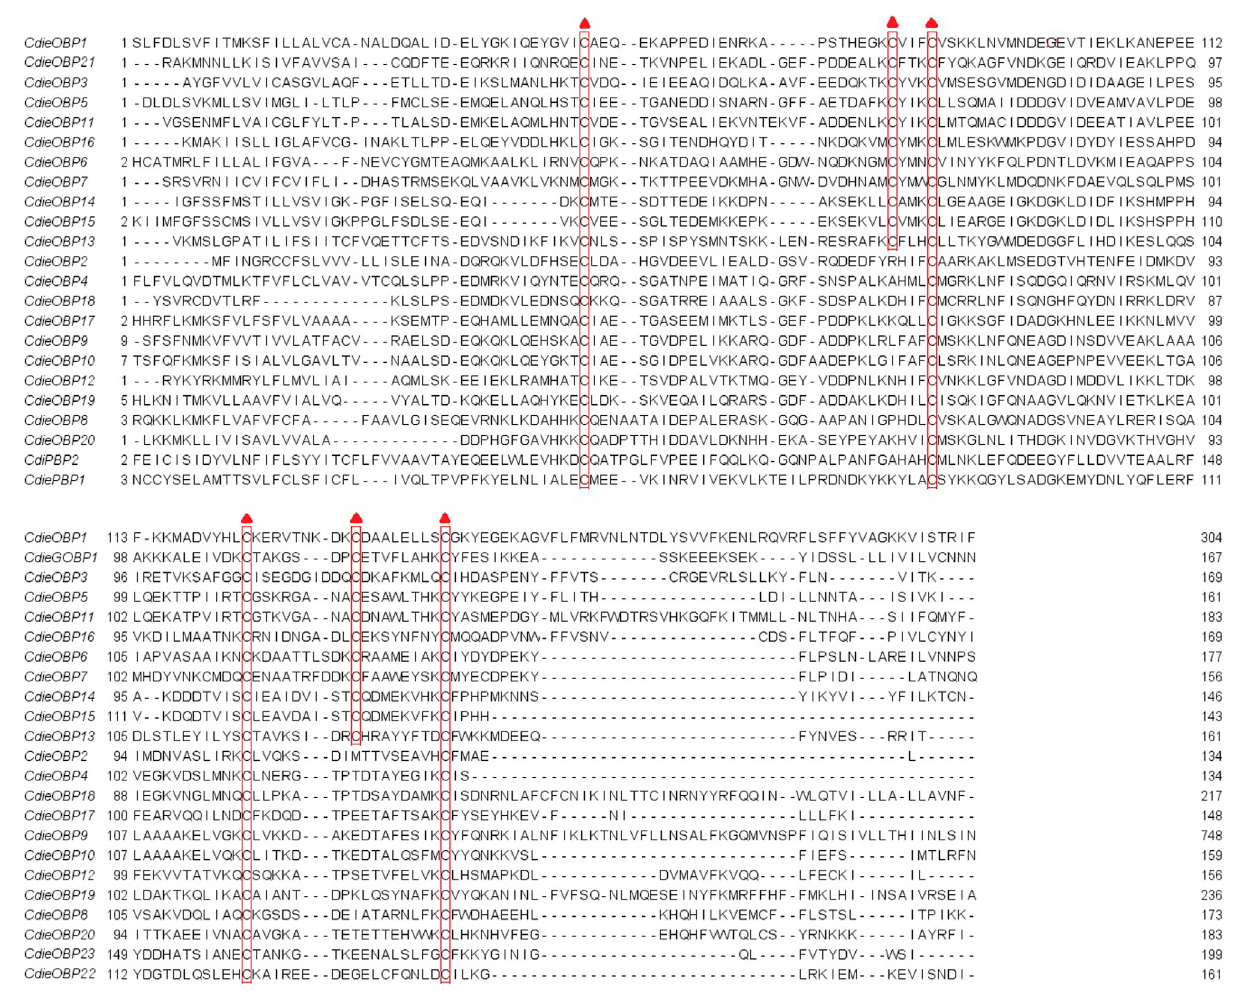
Frontiers in Physiology |